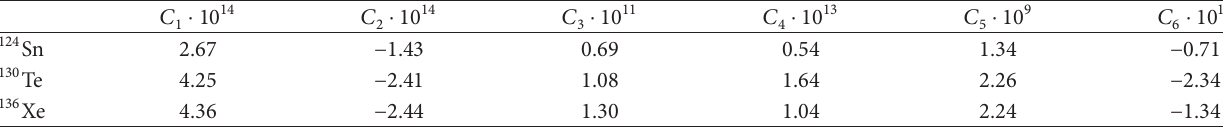
Table 3: 𝐶 𝑖 factors ( 𝑖 = 1,. . . , 6 ) corresponding to (3) expressed in [ yr −1 ] .